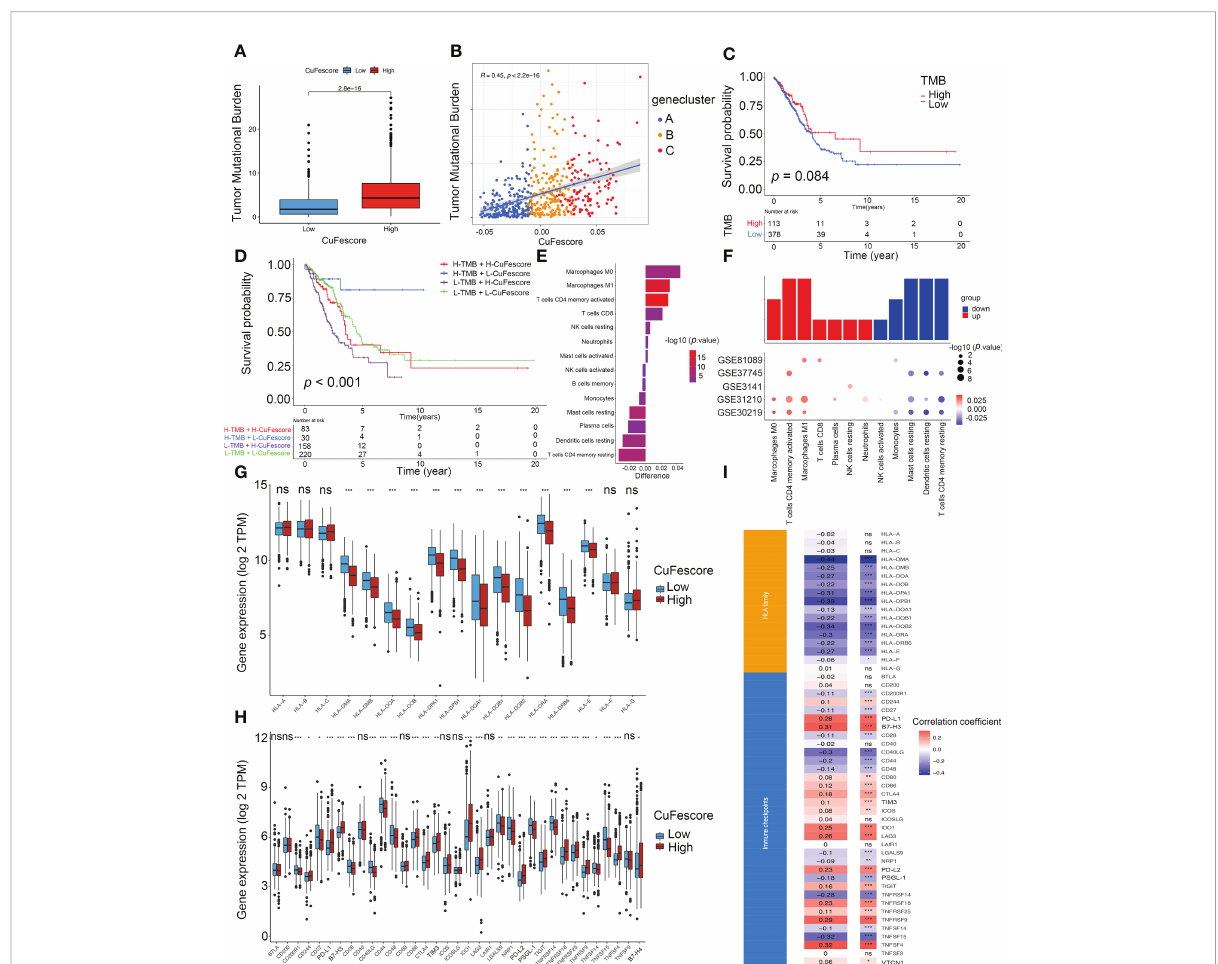
FIGURE 6 Correlation between the CuFescore and immune checkpoints. (A) Comparison of TMB in the high and low CuFescore group. (B) Correlation between CuFescore and TMB. (C) Kaplan-Meier curves of survival in the high and low TMB groups. (D) Survival analyses for patients strati fi ed by both CuFescore and TMB using Kaplan-Meier curves. (E) Difference in the relative abundance of immune cell in fi ltration in tumor microenvironment between the high and low CuFescore groups. Difference > 0 indicates that the immune cells were enriched in the low CuFescore group, and the column color represents the statistical signi fi cance of the difference. (F) Expression of cell types in the fi ve cohorts. Analyses for the expression of (G) HLA family genes and (H) immune checkpoints in the CuFescore groups. (I) Correlation analysis for CuFescore and the expression of HLA family genes and immune checkpoints. TMB, tumor mutational burden; TPM, transcript per million. * p < 0.05, ** p < 0.01, *** p < 0.001, ns, not signi fi